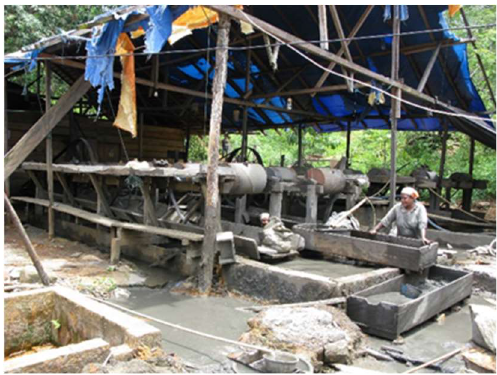
Figure 8. Female worker at an illegal ASGM, carrying out gold processing work without